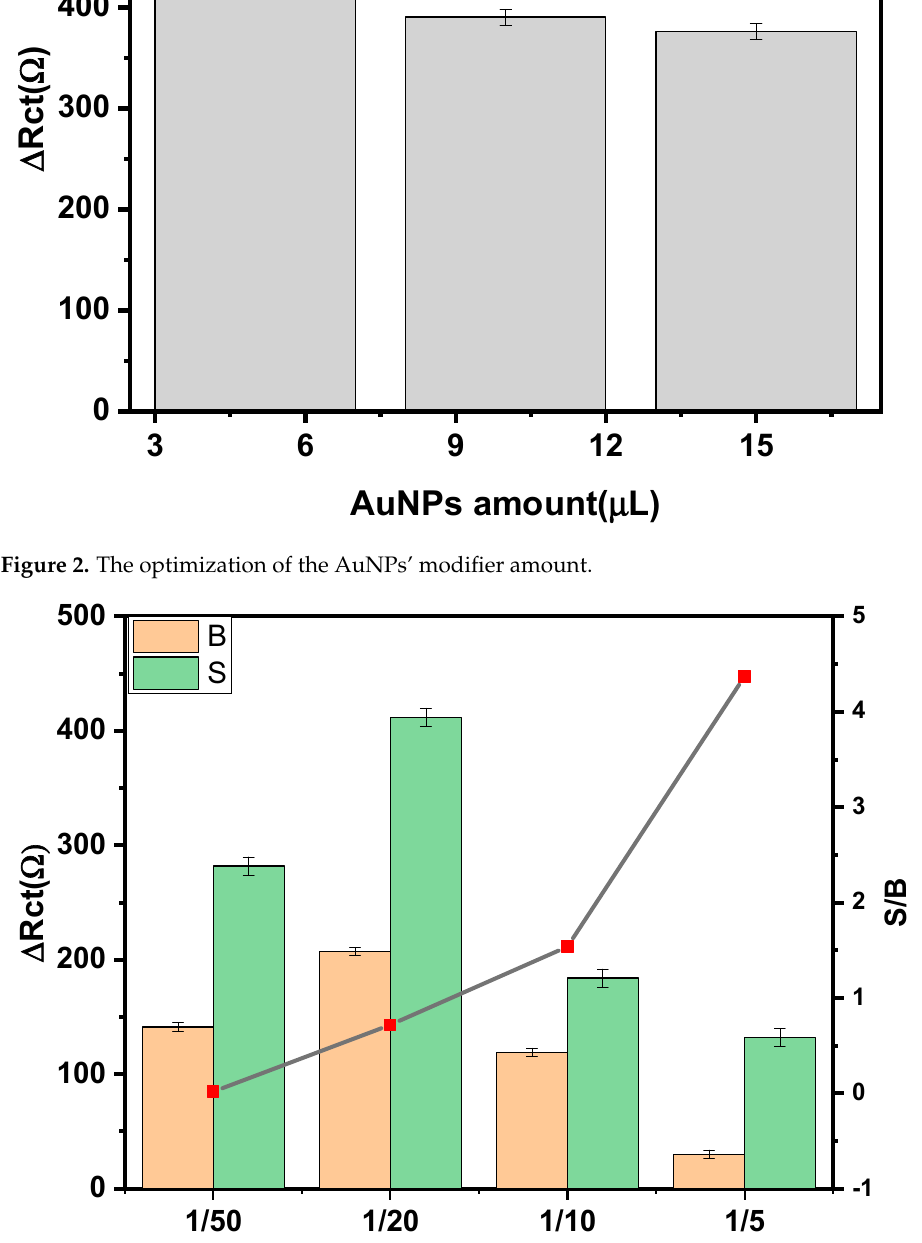
Figure 2. The optimization of the AuNPs’ modifier amount .